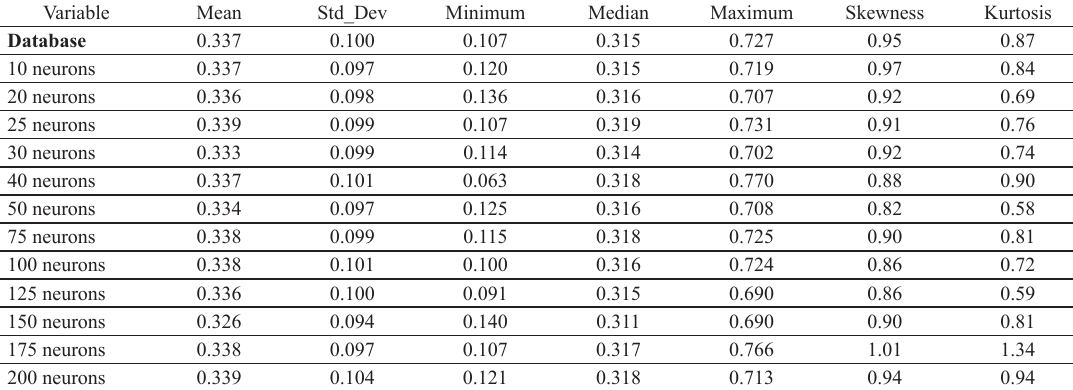
Table 14. Silicon variables (%).